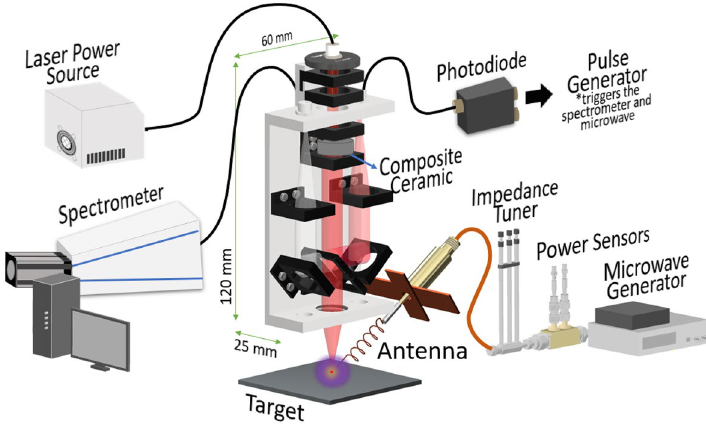
Figure 2. Schematic diagram of microwave-enhanced fiber-coupled micro-laser-induced breakdown spectroscopy (MWE-FC-MLIBS) using a ceramic micro-laser. The ceramic micro-laser composed of